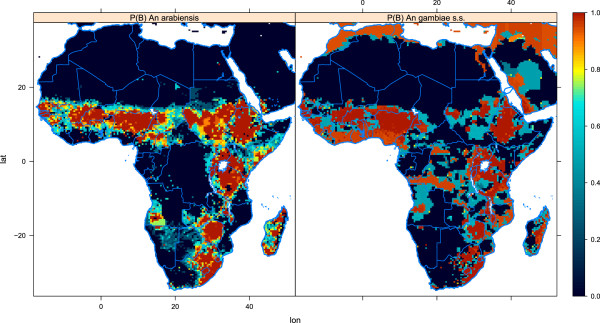
Probability of finding a blood meal for An. arabiensis (HBI = 0. 4 ) and An. gambiae s.s. (HBI = 0. 95) with zero bed net coverage.